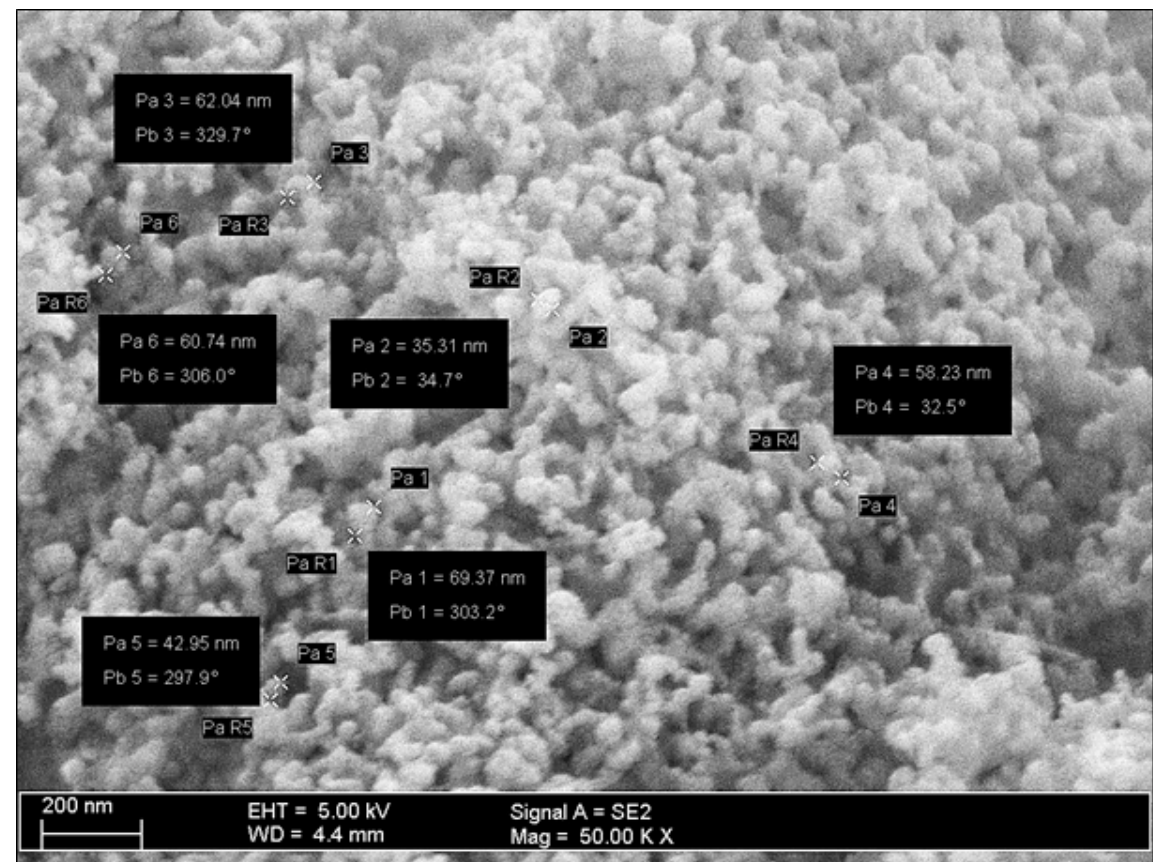
Figure 4. SEM image of the silica aerogel sample at 50,000× magnification.